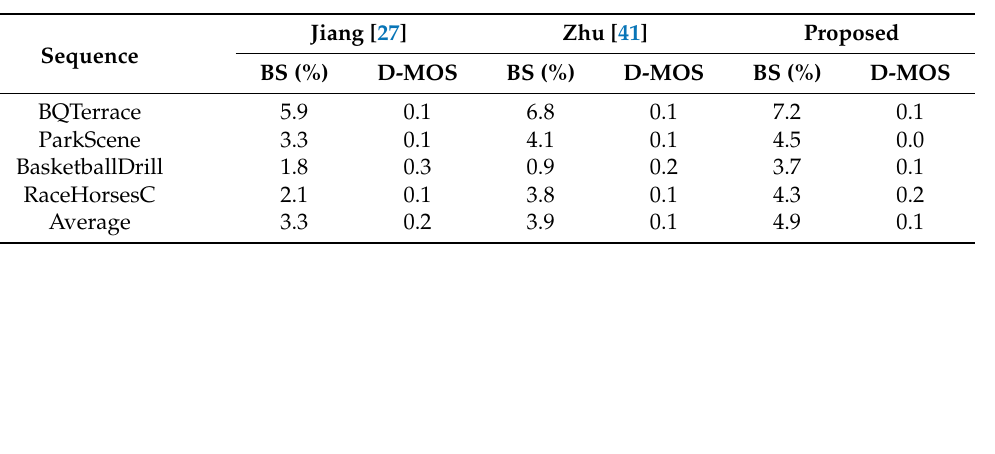
Table 4. Comparison of rate and Delta MOS